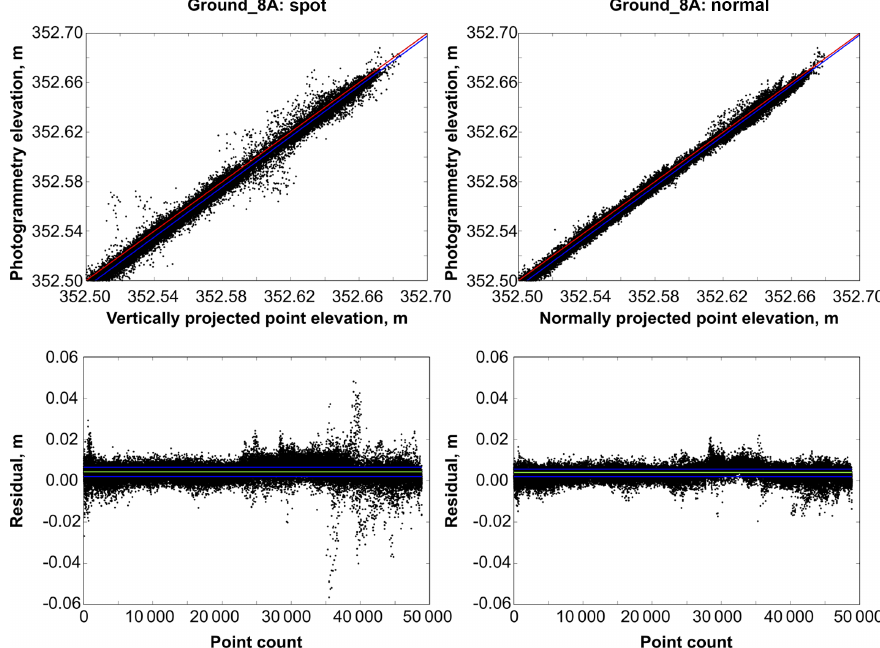
Figure 10. Four-photo pair (Ground_8A) spot elevation comparison (left column) and normal to plane comparison (right column) of pho- togrammetry and lidar point cloud data with a fitted line through the elevations (blue; spot) and the 1 : 1 line (red; spot); green is the mean residual and the blue lines are the 25th and 75th